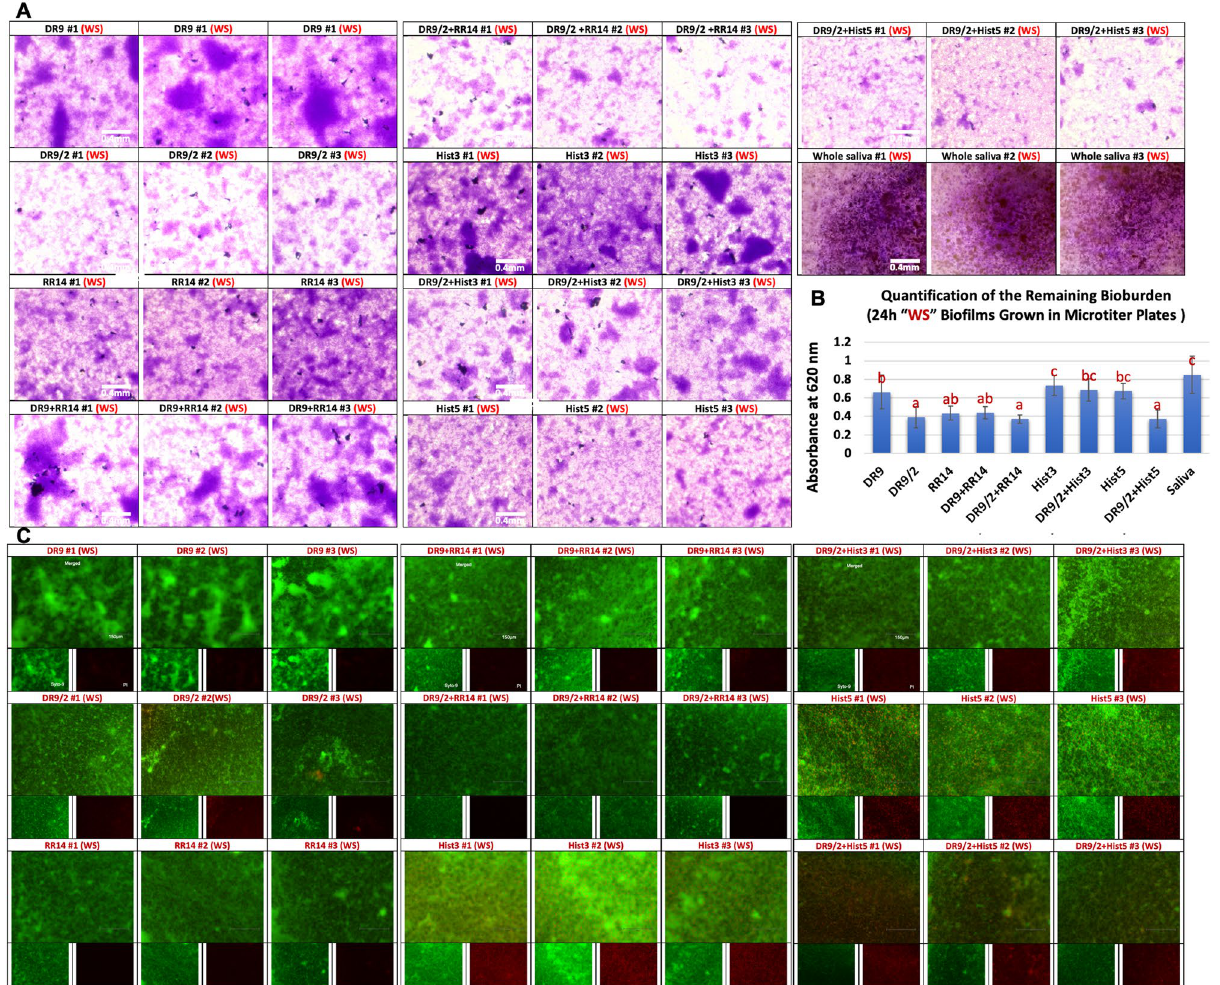
Figure 4. Biomass and vitality of biofilms grown in cariogenic conditions on pellicles of designed protein/ peptide constructs: ( A ) Inverted brightfield microscope characterization of the crystal violet-stained 24 h S. mutans U159 biofilms. All biofilms were grown in microtiter plates pellicle-coated with designed novel protein/ peptide constructs in comparison to native candidates. Filtered pooled whole saliva was used as a control. “WS” stands for “With Sucrose” where the biofilms were grown in BHI medium with 1% sucrose supplementation. Scale bar is 0.4 mm. ( B ) Quantification of the remaining bioburden after dissolving in 33% acetic acid. Distinct lower-case letters show significant differences among groups (ANOVA and Tukey’s (HSD) post-hoc tests, p < 0.05; Mean ± SD). ( C ) Inverted fluorescent microscope characterization of 24 h S. mutans U159 biofilms stained with Syto-9 “live/green” and Propidium-iodide “dead/red” stains. On each cluster, merged images are on the top and separated live channels are in the (bottom left) and dead channels are in the (bottom right). Scale bar is 150 μm. Hist3, Histatin3; Hist5,